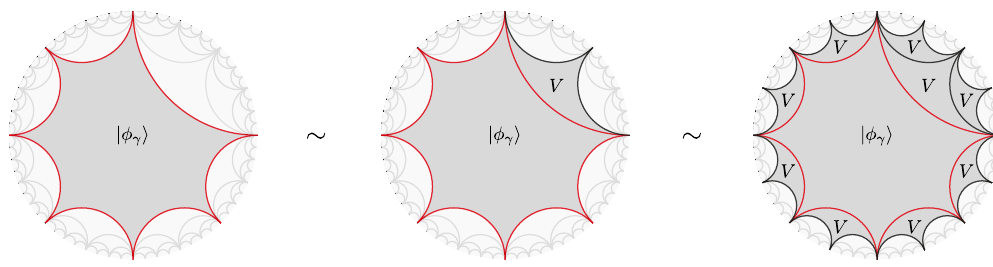
Figure 16 . Equivalent state vectors are interpreted as di(cid:11)erent (cid:12)ne-grainings of the same physical state. The fundamental (cid:12)ne-graining operation is application of the perfect tensor V , which acts as an isometry from one qudit to two